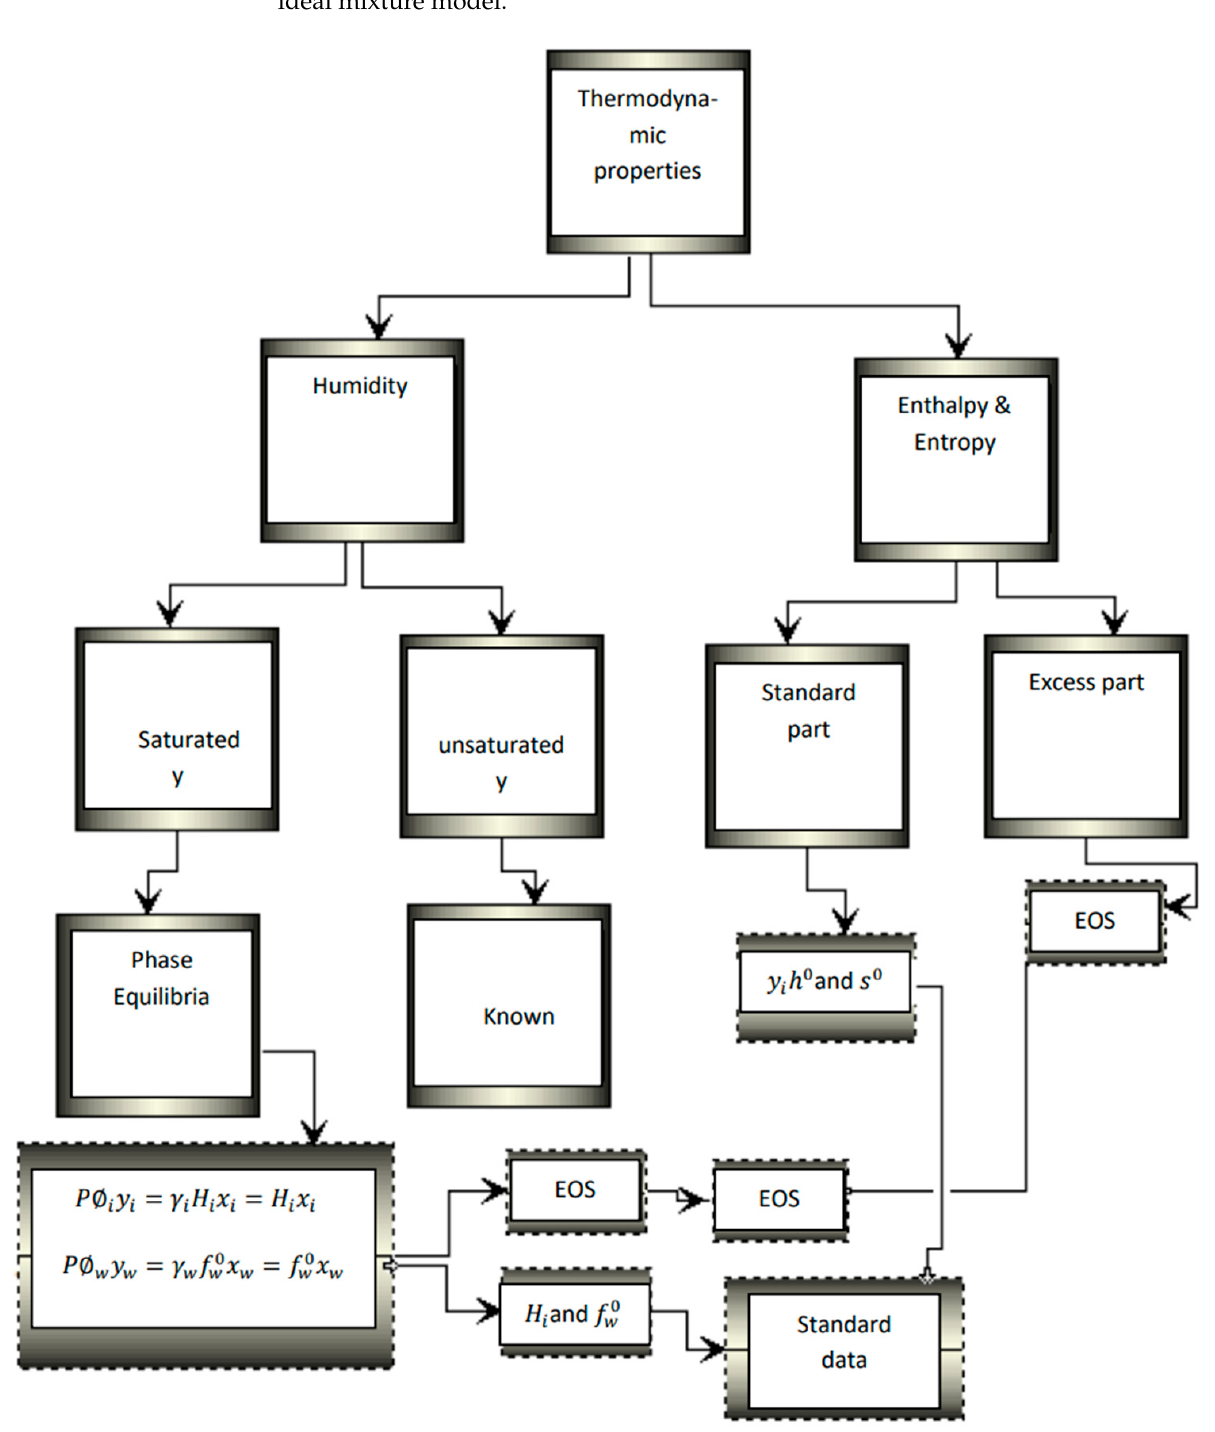
Figure 11. The calculation approach of thermodynamic properties for the air-water mixture with the real model.